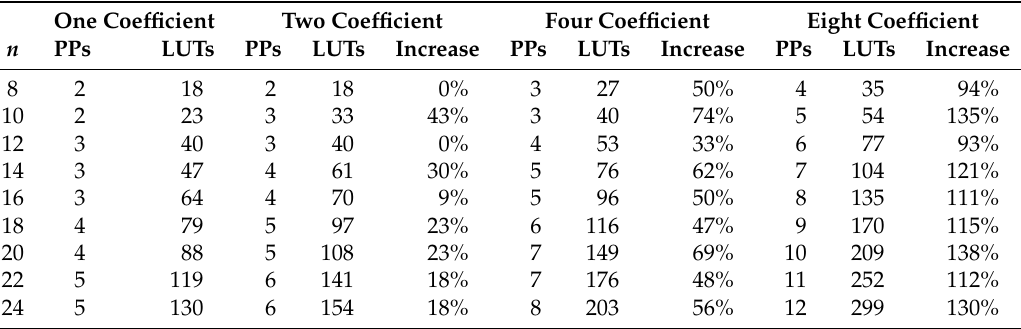
Table 1. Comparison of one, two, four and eight-coefficient ( m × n )-bit constant-coefficient multipliers (KCMs), where m = n . The increase in LUTs for multiple-coefficient KCMs is less than using separate KCMs with a multiplexer or a general-purpose multiplier with multiplexed constants.